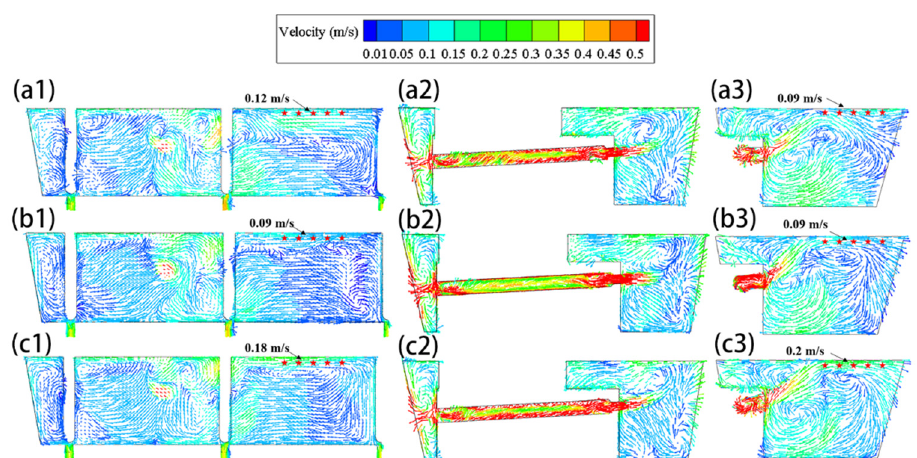
Figure 18. Velocity vectors of split channel schemes in the planes passing through the center of all outlets (left), “Channel out1” (middle) and split port (right): ( a1 – a3 ) FK-A0; ( b1 – b3 ) FK-A5; ( c1 – c3 ) FK-A15.